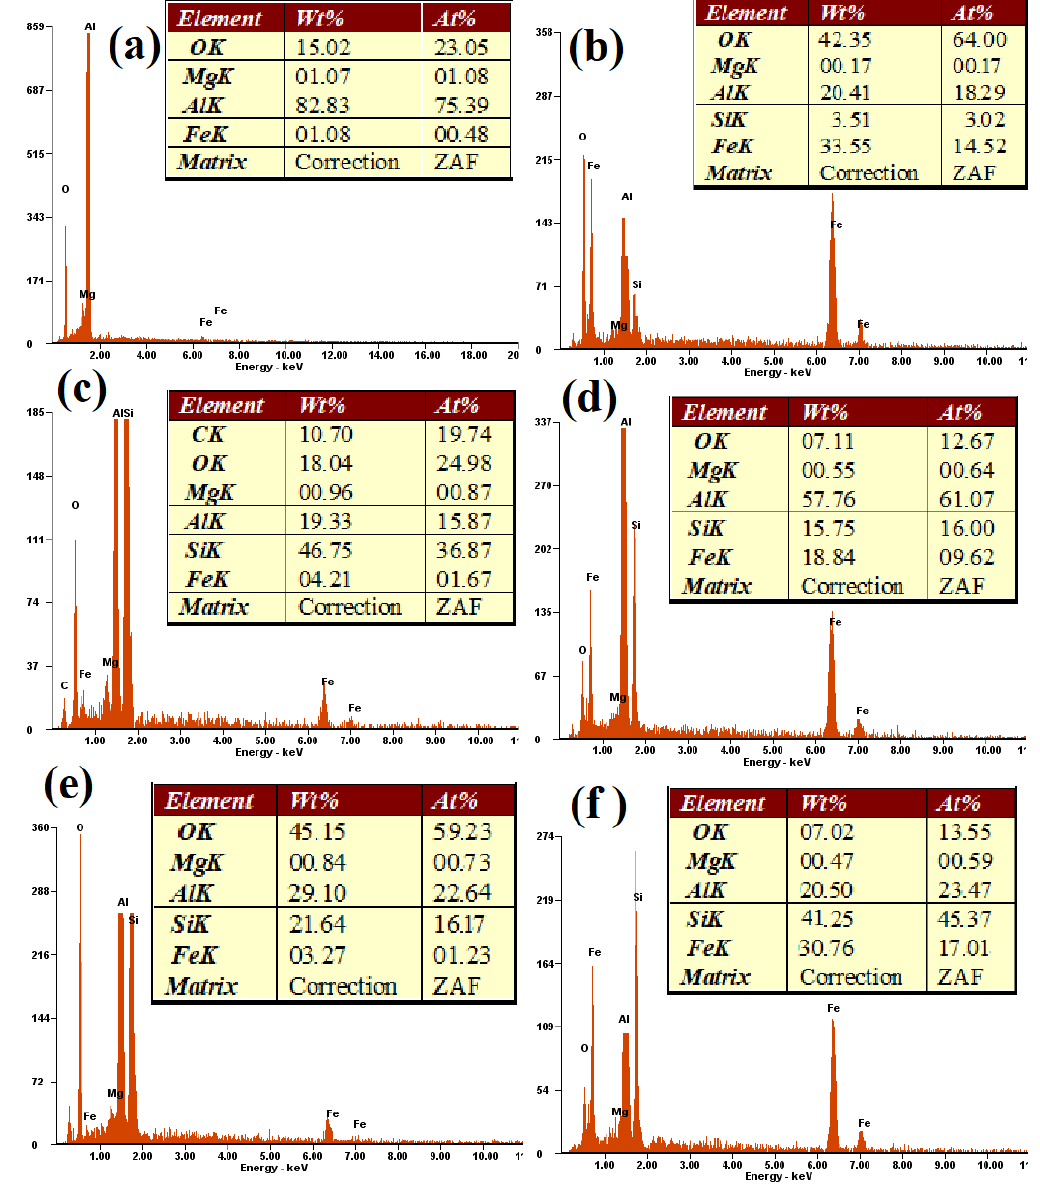
Figure 5. The EDS spectrum of Al-30Fe 3 O 4 -20SiC composition: ( a ) aluminum, ( b ) Fe 3 O 4 , ( c ) SiC, ( d ) Al 3 Fe, ( e ) Al 2 O 3 , and ( f ) Al 2 Fe 3 Si 4 .